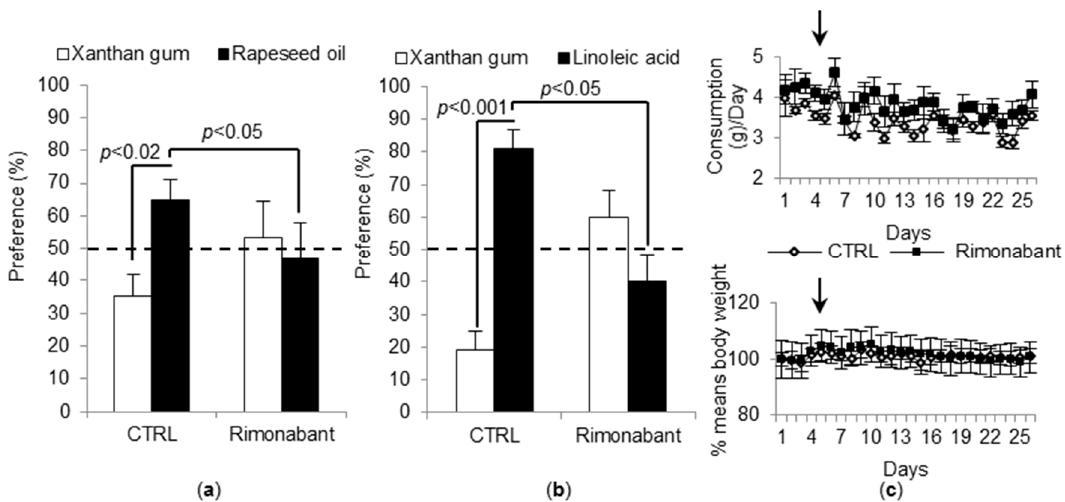
Figure 2. Effect of rimonabant on preference for lipids, body weight, and feeding behavior. ( a , b ) WT mice, treated with either rimonabant (10 mg ∙ kg − 1 ∙ day − 1 ) or vehicle (CTRL), were simultaneously offered two bottles, a control one and an experimental one. The latter bottle contained either 0.2% of rapeseed oil ( w / v ) ( a ) or 0.2% of linoleic acid ( w / v ) ( b ) diluted in xanthan gum. Control solution contained 0.3% of xanthan gum. Values are expressed as mean ± SEM ( n = 5). Dotted line represents the absence of preference in rimonabant ‐ treated mice (less than 50% of preference). ( c ) Food intake and body weight variations in mice treated or not with rimonabant and fed a standard chow. Values are expressed as mean ± SEM ( n = 5). Black arrows indicate the beginning of the treatment with rimonabant. 3.3. CD36 and GPR120 Protein Expressions Are Not Altered in TBC of CB 1 R − / − Mice CB 1 R gene invalidation did not interfere with CD36 and GPR120 protein expression in taste buds from CB 1 R − / − (Figure 3). α -Gustducin, a marker of type II TBC, remained stable (Figure 3). It seems that the low preference for fatty solutions observed in CB 1 R − / − mice was not due to altered expression of CD36 and GPR120.